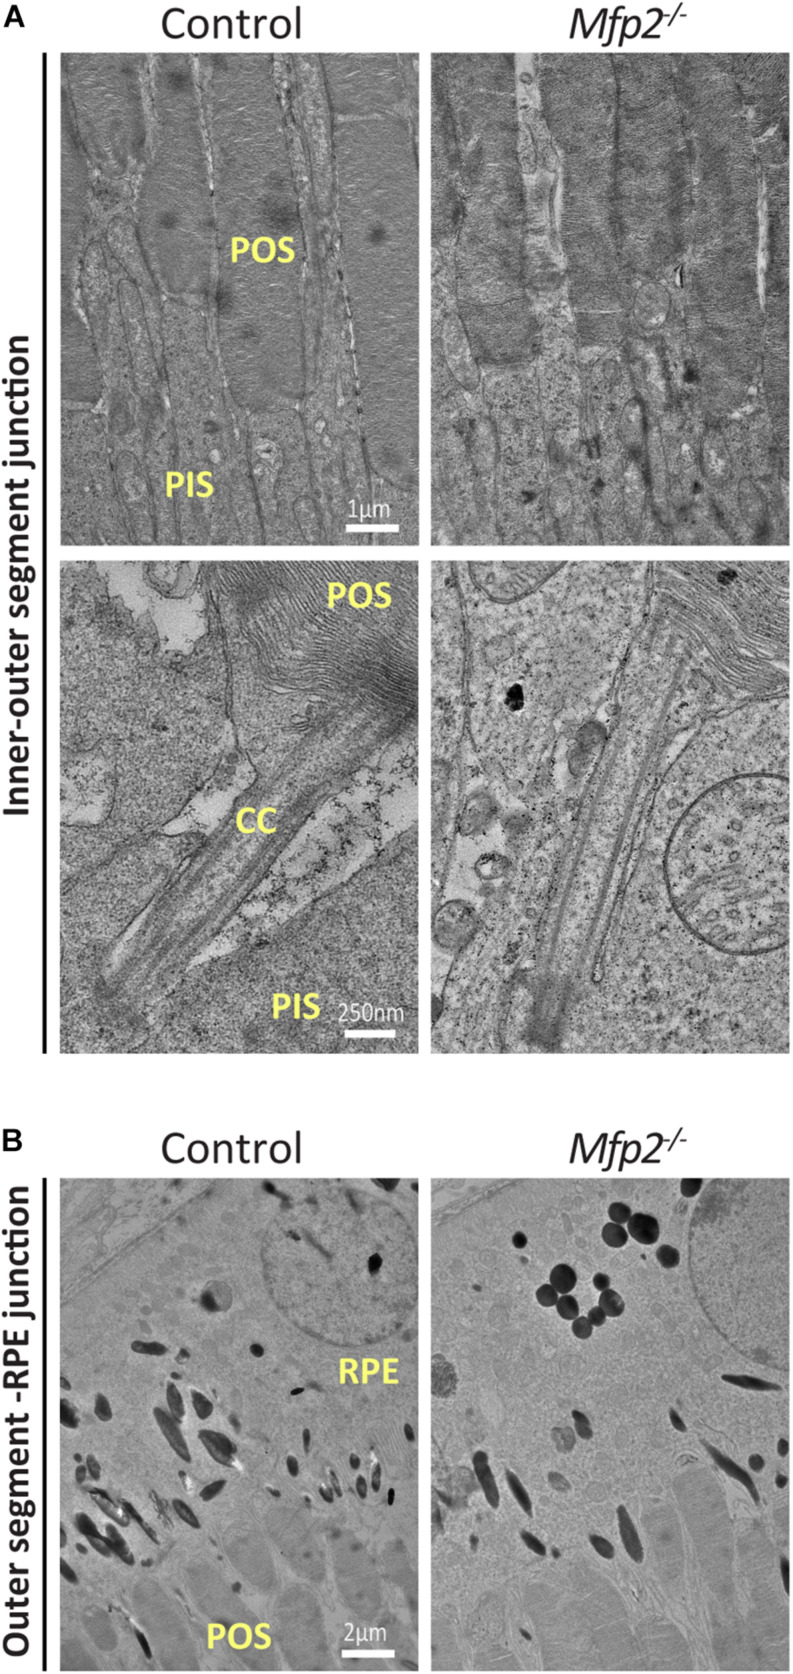
Normal POS formation in Mfp2–/– mice. TEM analysis reveals (A) unaltered POS disc organization and density and normal connecting cilium appearance and (B) normal contact of the POS with RPE cells in 3 weeks-old Mfp2–/– mice (n = 3-5 per genotype). CC, connecting cilium; POS, photoreceptor outer segment; PIS, photoreceptor inner segment; RPE, retinal pigment epithelium.